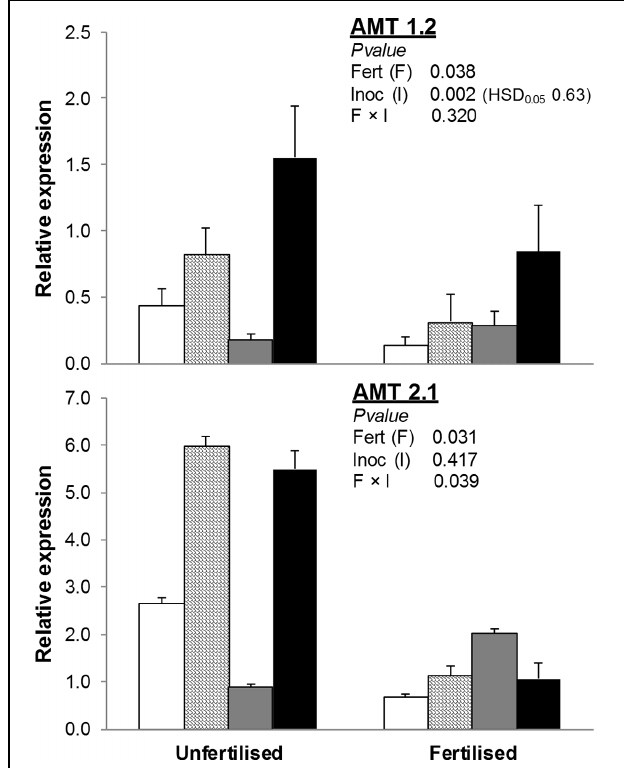
FIGURE 3 | Expression of ammonium transporter genes ( AMT1.2, AMT2.1 ) in T. durum root. Plants were grown under the unfertilized conditions or fertilized with an organic fertilized with low C:N ratio. Soil was left with the NAT (white bars); inoculated with only AMF spores (scaled bars); only plant PGPR (gray bars), or both AMF + PGPR (black bars). Means ( n = 6) with standard errors and analysis of variance results are shown. Fert is for fertilization treatment, Inoc for Inocula. Tukey’s HSD 0 . 05 of Inocula is shown when Inocula, but not Fertilizer × Inocula interaction, is